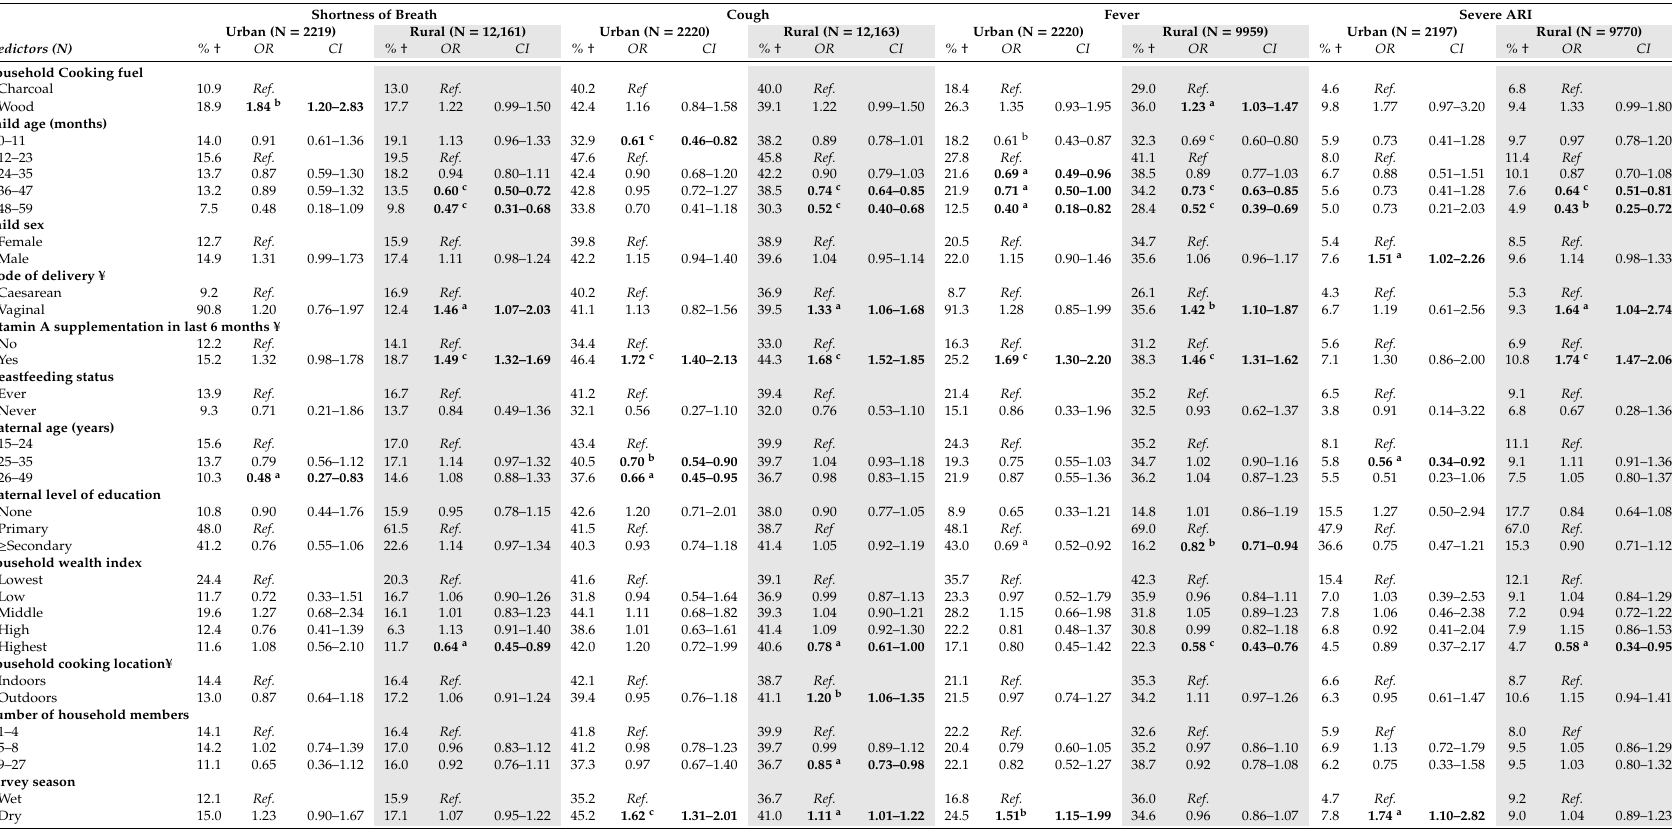
Table 3. Adjusted logistic regression analyses for urban and rural study sub-populations (N = 2426, N =